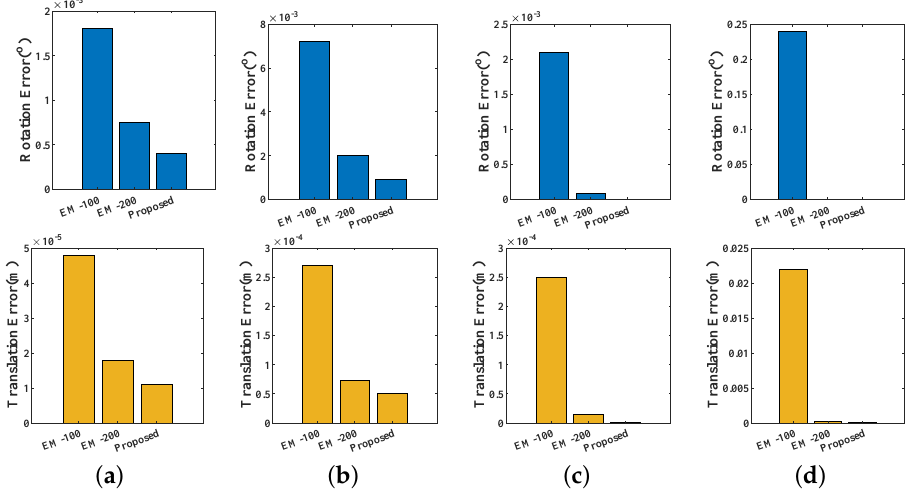
Figure 9. The rotation errors and translation errors of the GMM registrations.EM-100 and EM-200 are the EM-trained GMM using 100 and 200 components, respectively. ( a ) Corner; ( b ) Office; ( c ) Street; ( d )